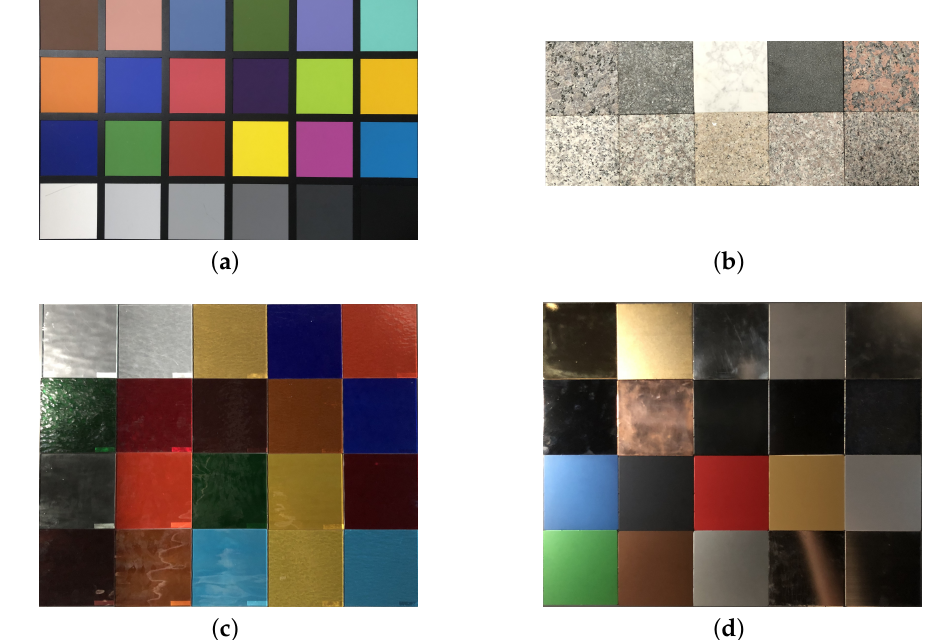
Figure 2. A standard colour checker board and common materials that appeared in the urban